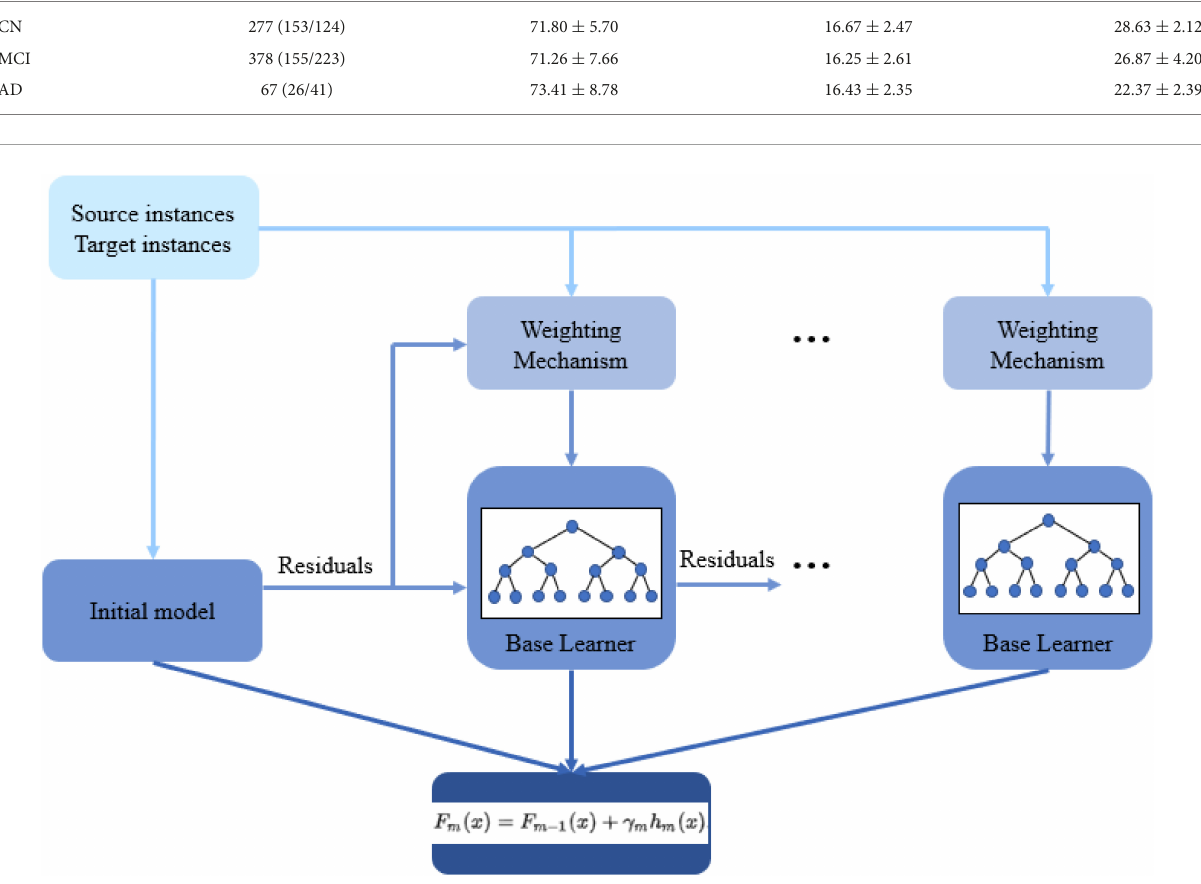
TABLE 1 Participant demographics and mini-mental state examination (MMSE) score for different diagnosis groups of the ADNI3 cohort. Groups